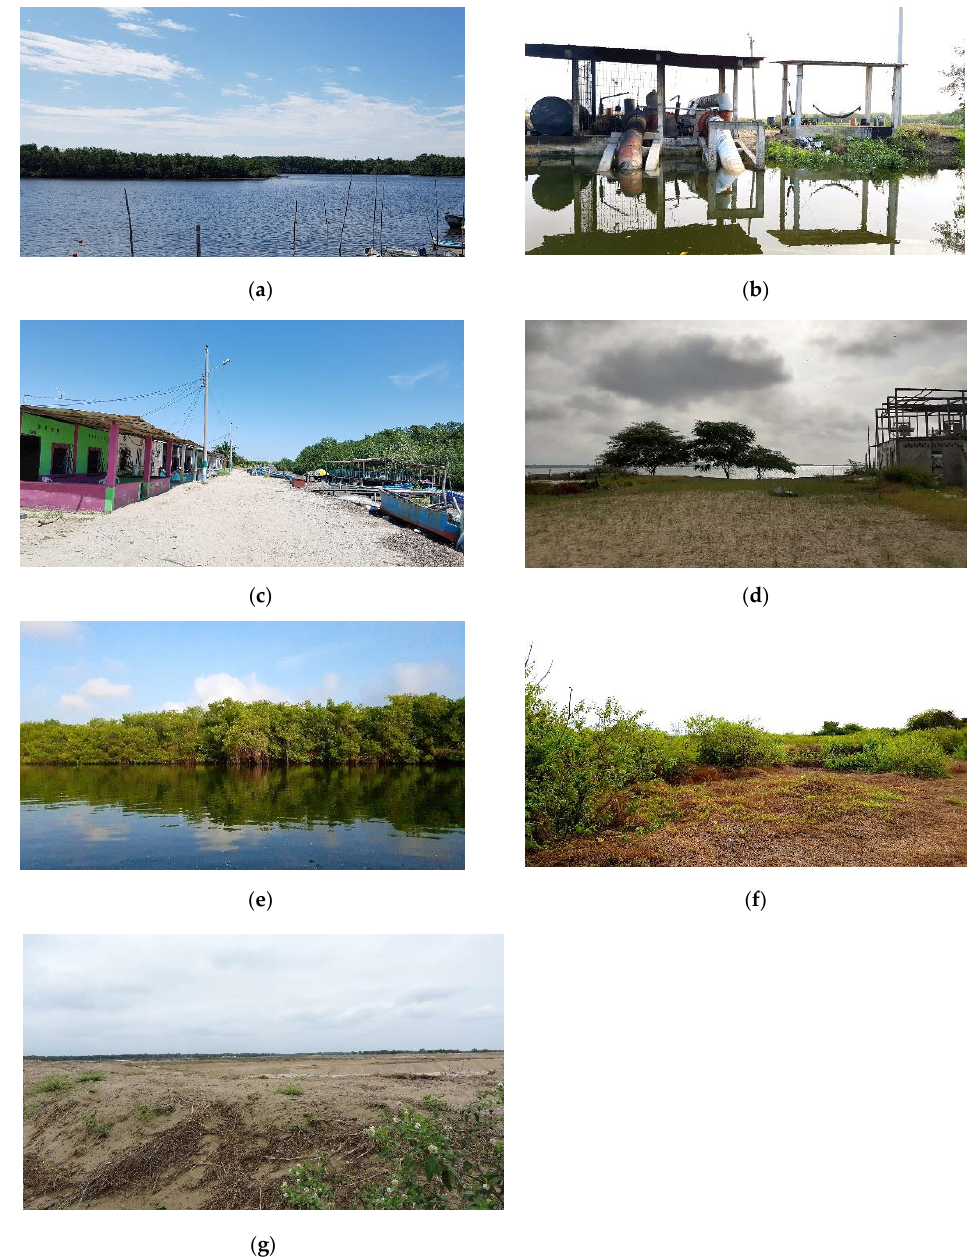
Figure 2. Representation of land use and land cover categories: ( a ) water; ( b ) shrimp farming; ( c ) built-up area; ( d ) cropland; ( e ) mangrove; ( f ) natural vegetation; and ( g ) bare land. After establishing the classification scheme, we digitized LULC maps for two periods (1998 – 2010; 2010 – 2018). We used a frequently applied method consisting of visual interpretation followed by on-screen digitizing [29]. This method avoids errors that are generated when using automatic classification methods. On-screen digitizing is a way to trace features from images. This is one of the most accurate techniques for characterizing land cover [35]. For the visual interpretation of satellite images, we created false color composites. For Landsat imagery, we applied an RGB composite using near infrared (NIR), shortwave infrared (SWIR), and red bands. For Sentinel 2A imagery, we applied a band composite using vegetation red edge, shortwave infrared (SWIR), and red bands (Figure 3). These composites are capable of distinguishing mangrove forest from the surrounding objects more clearly [36].